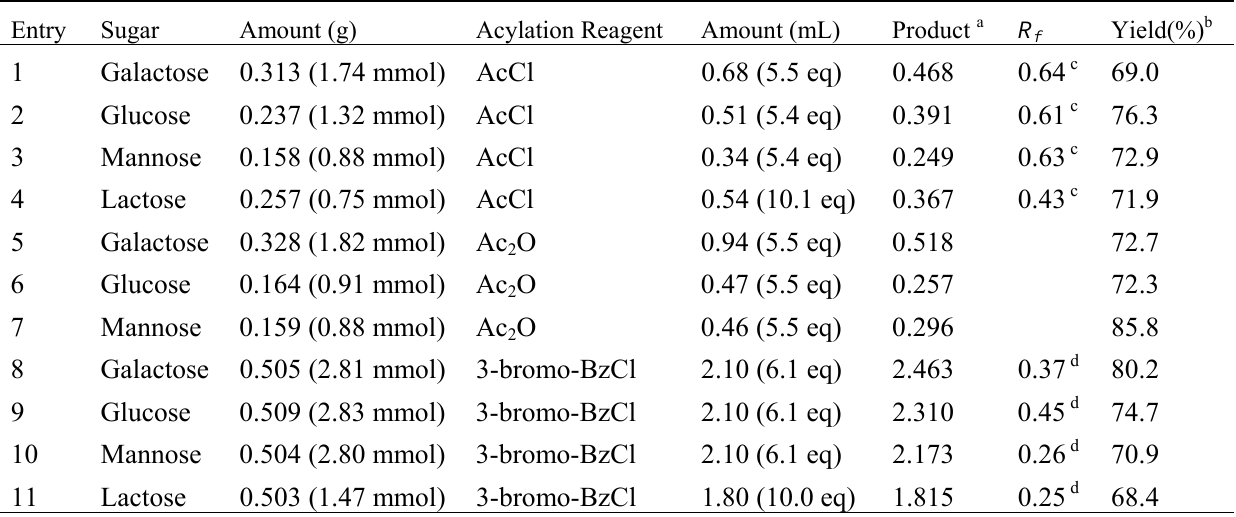
Table 1. The experimental details of the acetylation and (3-bromo)benzoylation of